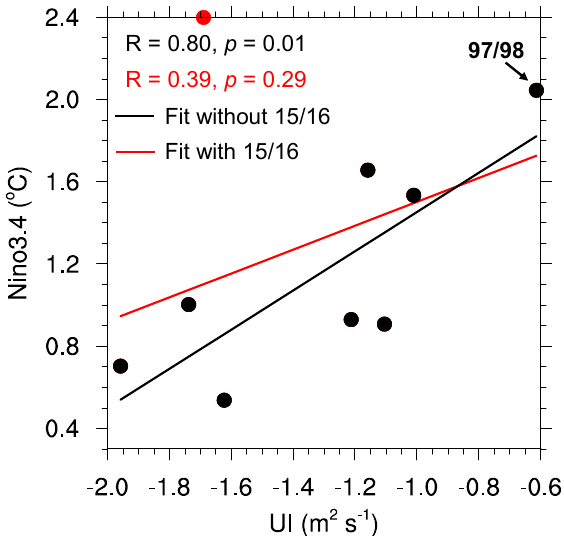
Figure 3. Relationship of August upwelling index (negative means offshore Ekman transport) and D(0)JF( + 1) Niño3.4 index. Red line and black line indicate the linear fitting with, and without, 2015/16, respectively.